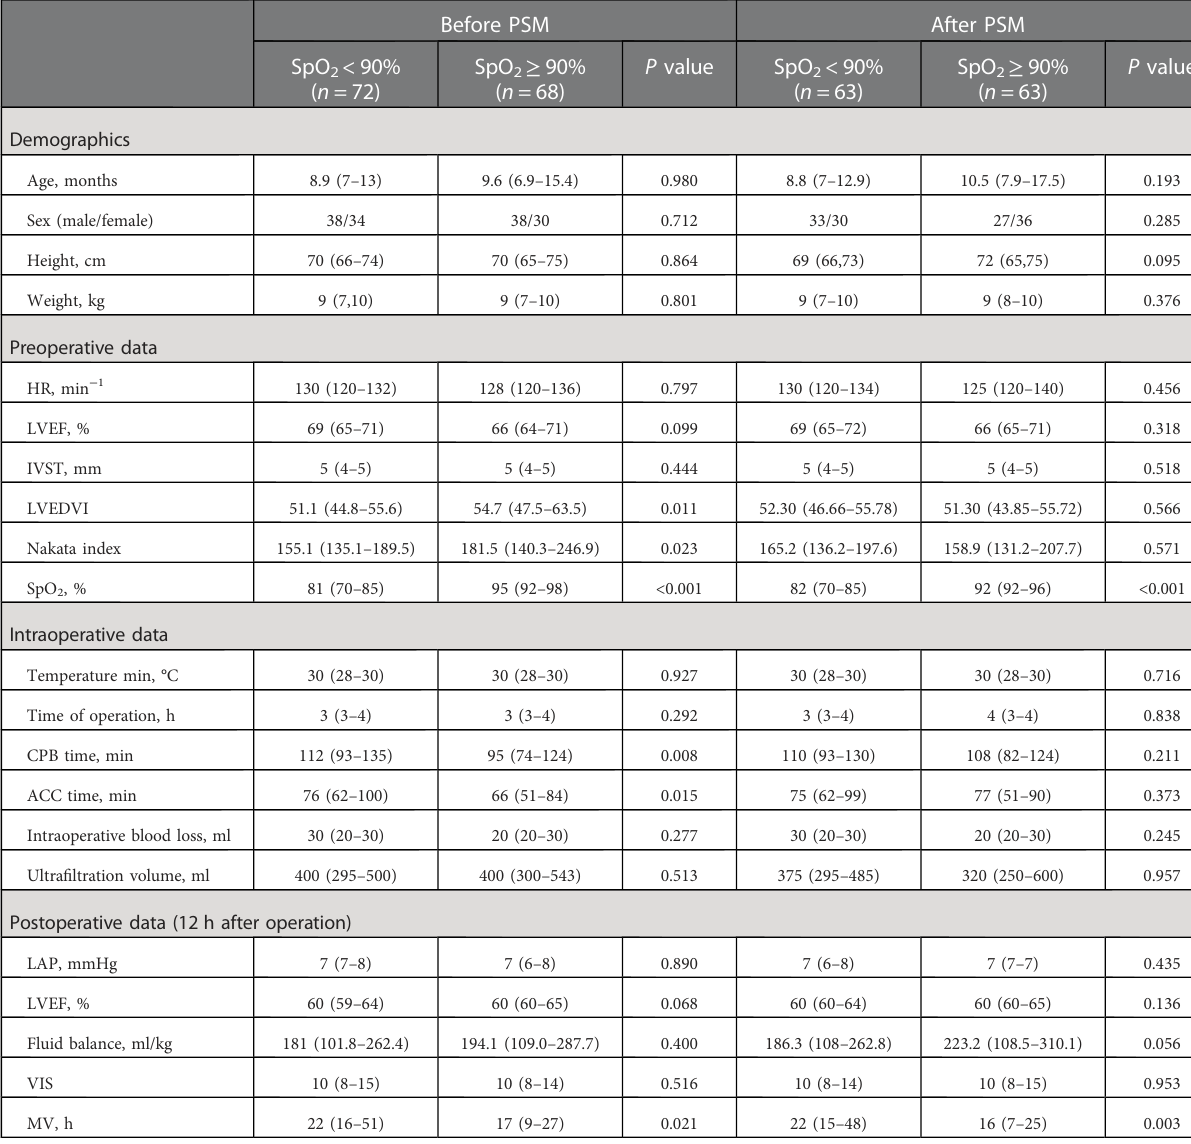
TABLE 1 Demographic and clinical data of TOF